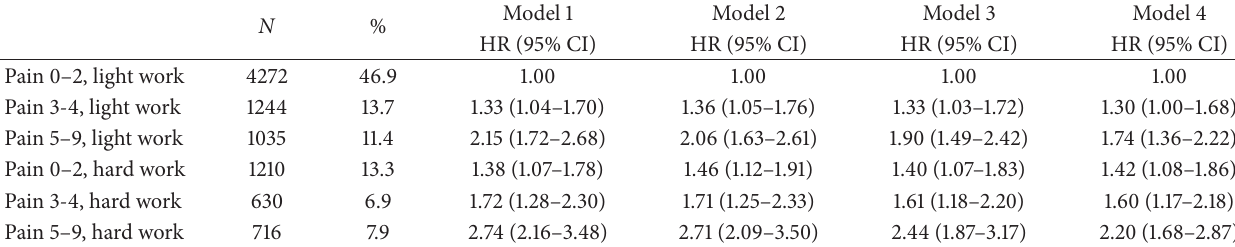
Table 2: The prospective associations between back pain intensity, physical activity at work, and risk of LTSA. Model 1 N %